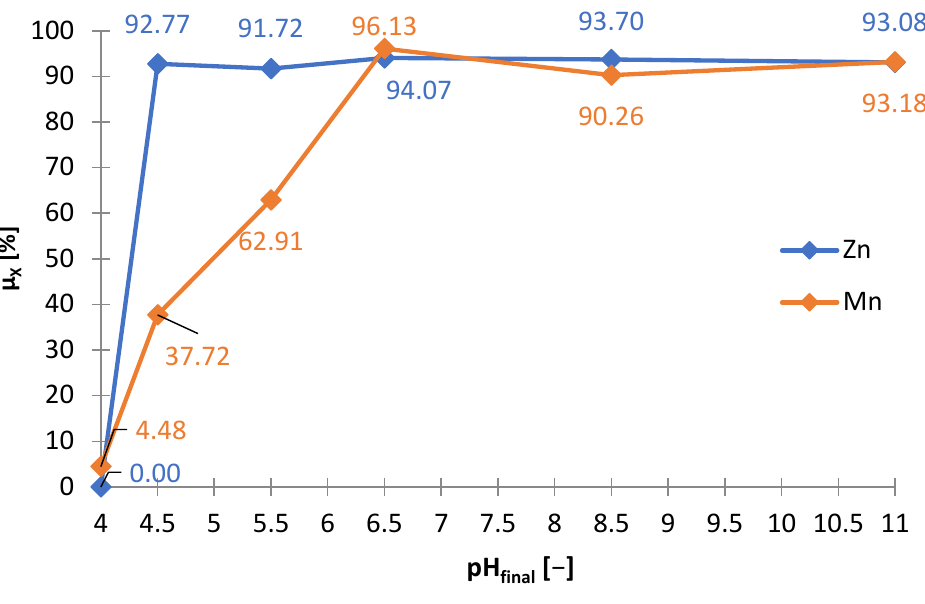
Figure 23. Effect of final pH (pH final ) on precipitation yields ( µ X ) of zinc and manganese during precipitation by using Na 3 PO 4 from solution after selective leaching.